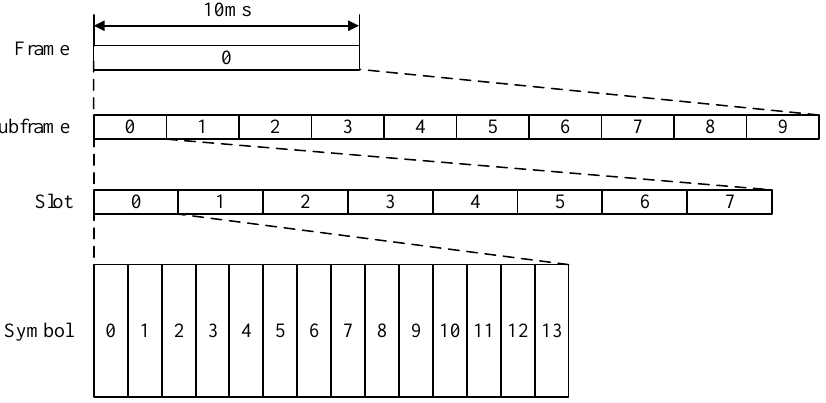
Figure 8. The frame structure. Each frame is divided into 80 slots. Each slot is further divided into 14 OFDM